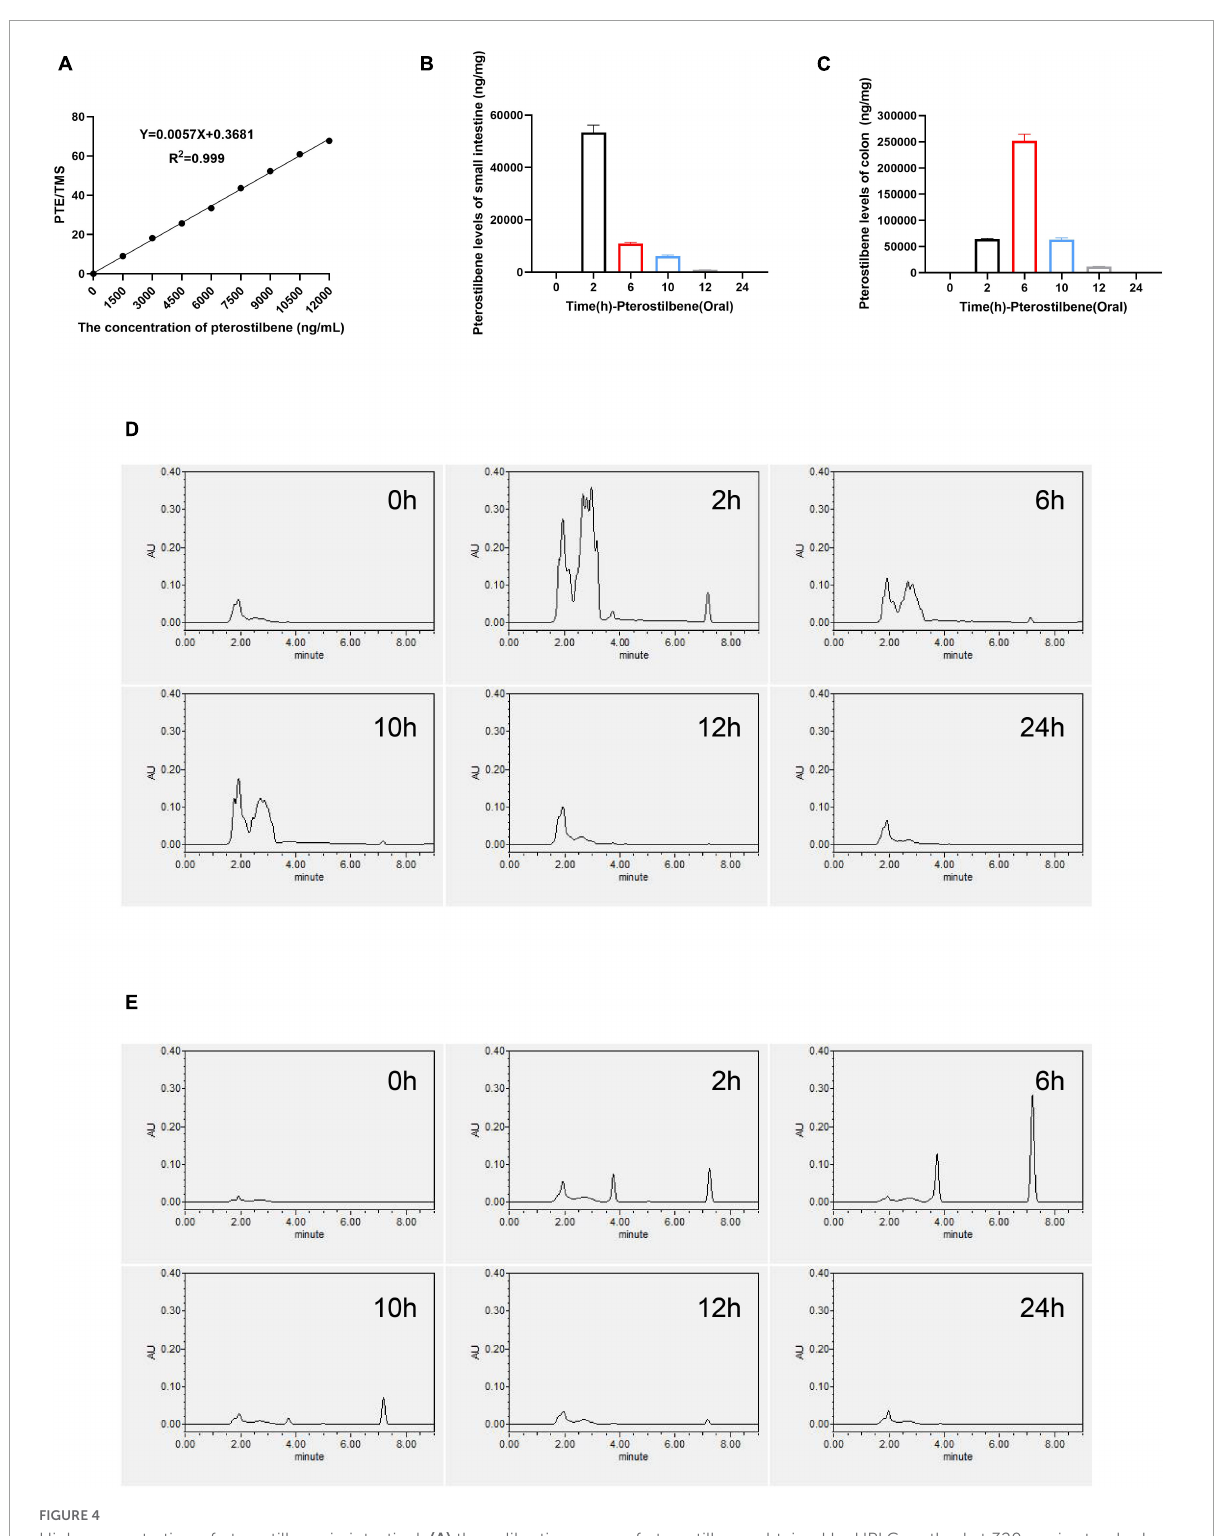
FIGURE4 High concentration of pterostilbene in intestinal. (A) the calibration curve of pterostilbene obtained by HPLC method at 320 nm in standard solution. (B,C) Levels of small intestinal and colon gavaged with pterostilbene (100 mg/kg/day). (D) Pterostilbene chromatograms of small intestinal. (E) Pterostilbene chromatograms of colon. Data were expressed as means ±